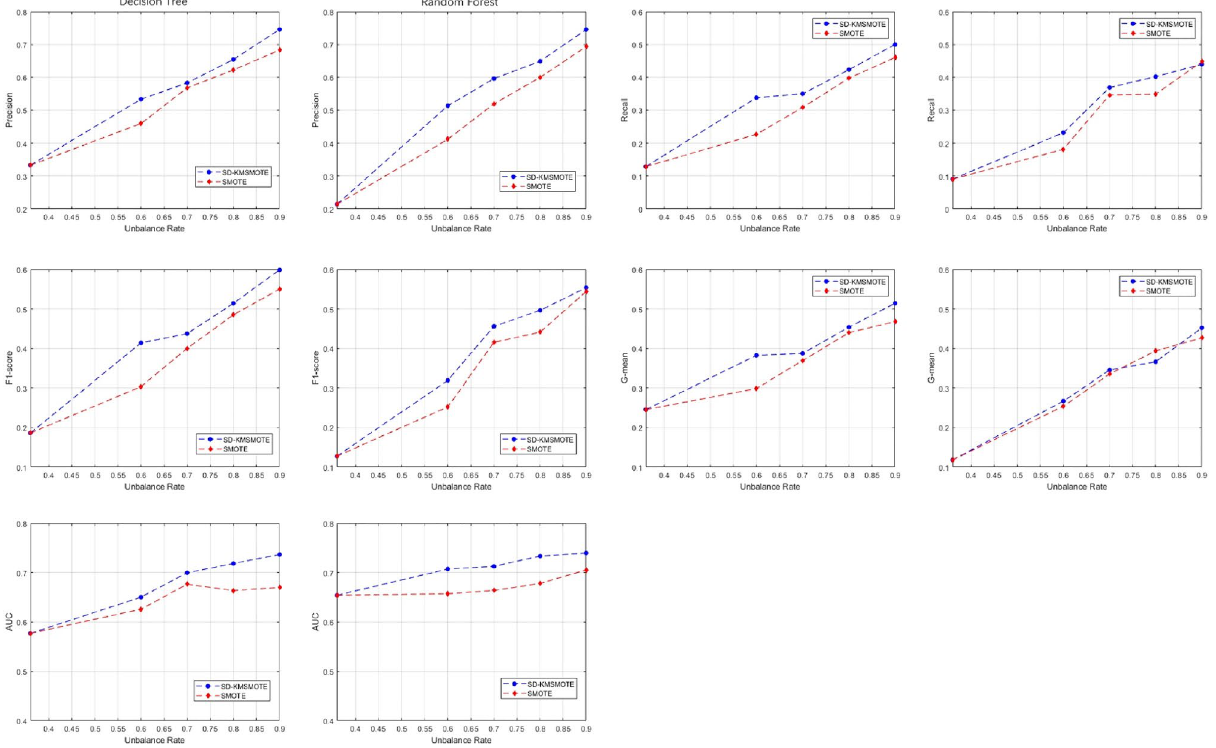
Figure 4. Comparison of evaluation indexes of Haberman under different equilibrium